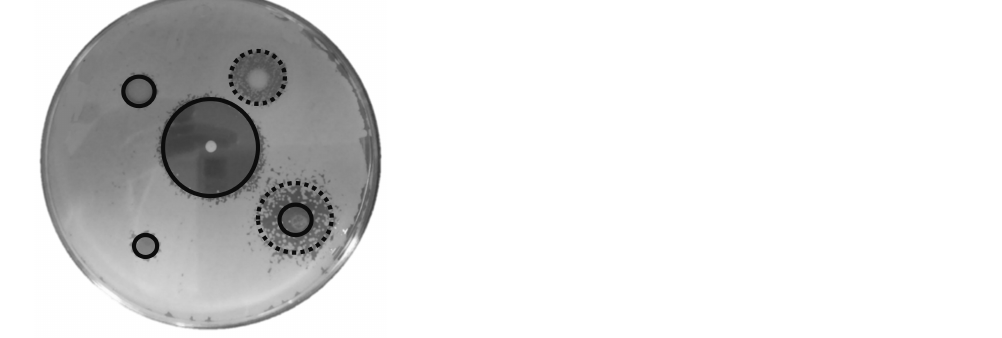
Figure 3. Inhibition halo of yeast growth in presence of antifungals assayed. Black line/circle repre- sents total inhibition of the yeast growth, and dotted line/circle represents partial inhibition of the yeast growth.